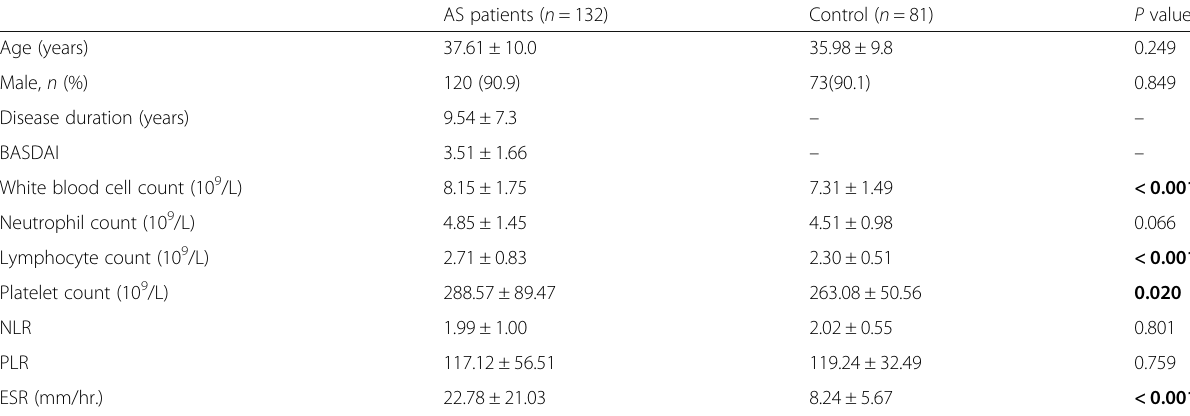
Table 1 Demographic, clinical and laboratory characteristics of AS patients and controls AS patients ( n =